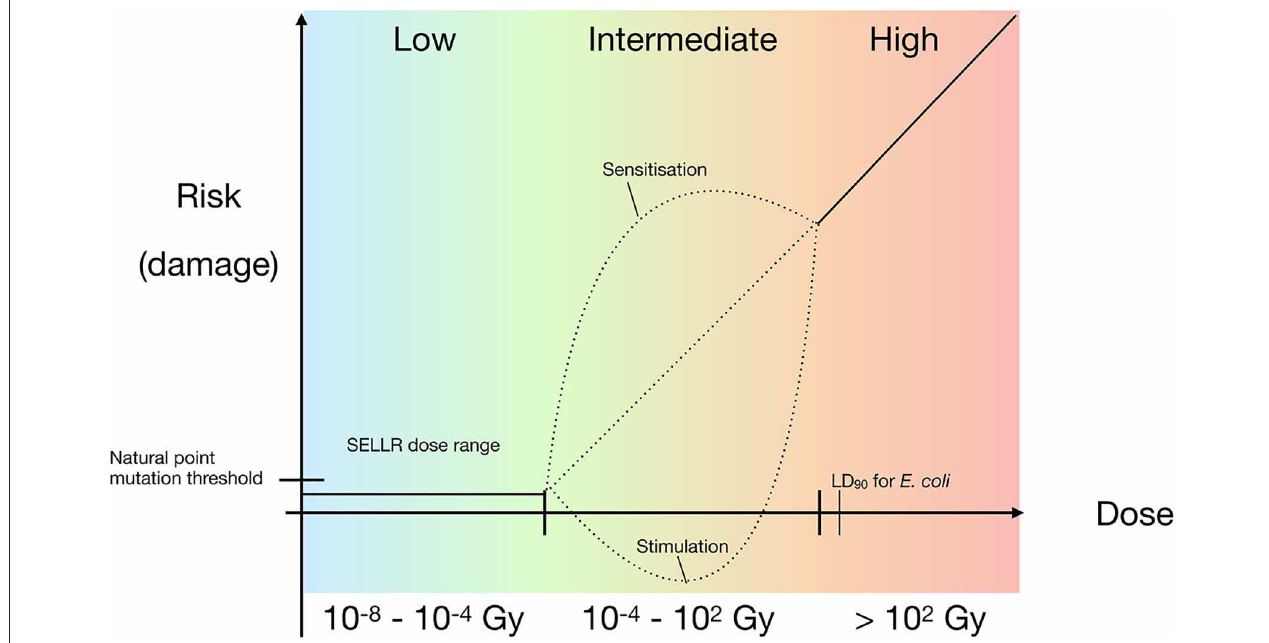
FIGURE 8 | Updated prokaryotic dose-response model with a linear relationship for higher doses and added SELLR (Subsurface Experiment of Life in Low Radiation) observations from sub-background to 100 × background, representing the “low” dose range where we observe no difference in growth. Black dotted lines indicate hypothetical risk of damage at intermediate radiation exposure, which requires further research.